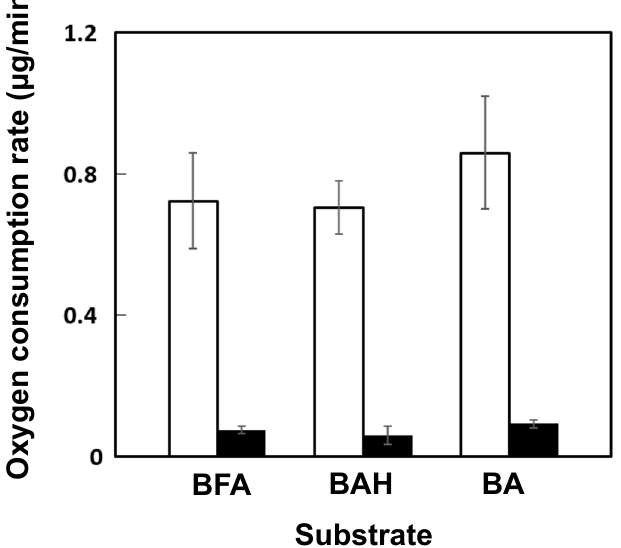
Figure 5. Oxygen consumption by strain LLC-1 grown with benzoylformic acid (white box) or pyruvic acid (black box). The cell suspensions (at OD 600 of 2.0) were incubated with 150 µ M benzoylformic acid (BFA), benzaldehyde (BAH), or benzoic acid (BA). Dissolved dioxygen in a chamber was monitored as described in Materials and Methods. Experiments were performed in triplicates, and standard deviations are displayed as error bars.